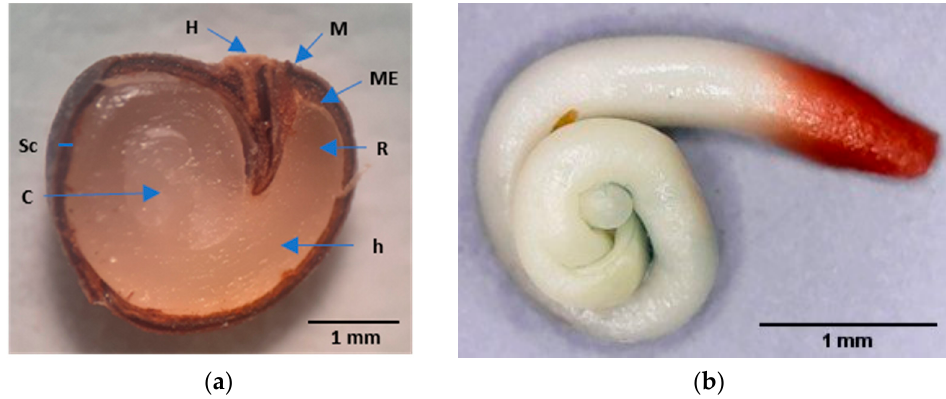
Figure 1. Caper seed. ( a ) Longitudinal section of a mature caper seed after soaking in water for four days. H, hilum; M, micropyle; ME, micropylar endosperm; R, radicle; h, hypocotyl; Sc, seed coat; and C, cotyledons; ( b ) Embryo with a stained radicle with tetrazolium.